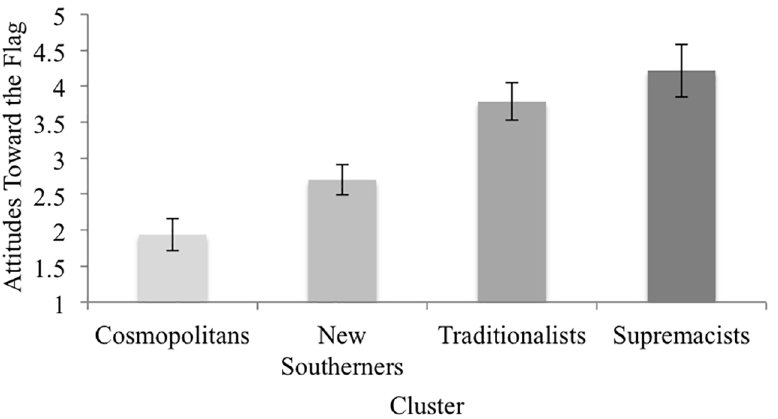
Figure 2. Estimated marginal means for ATF by cluster. Errors bars are 95% confidence